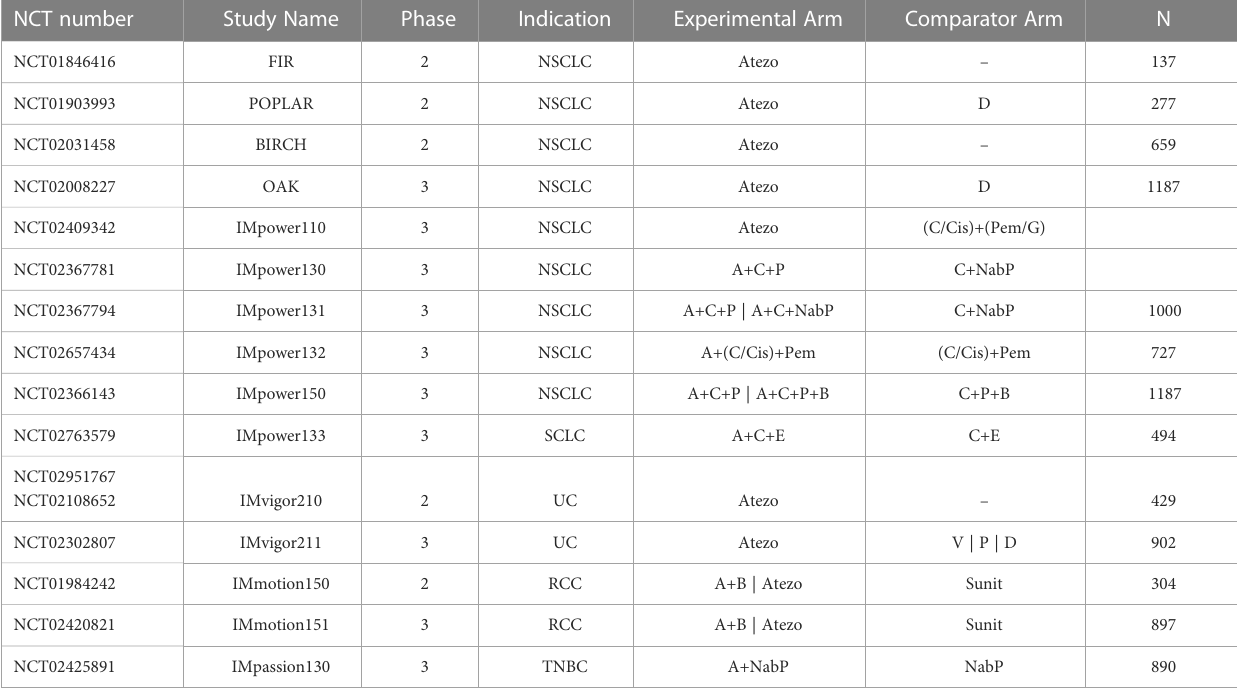
TABLE 1 Internal atezolizumab trials with number of patients (N) in the safety evaluable